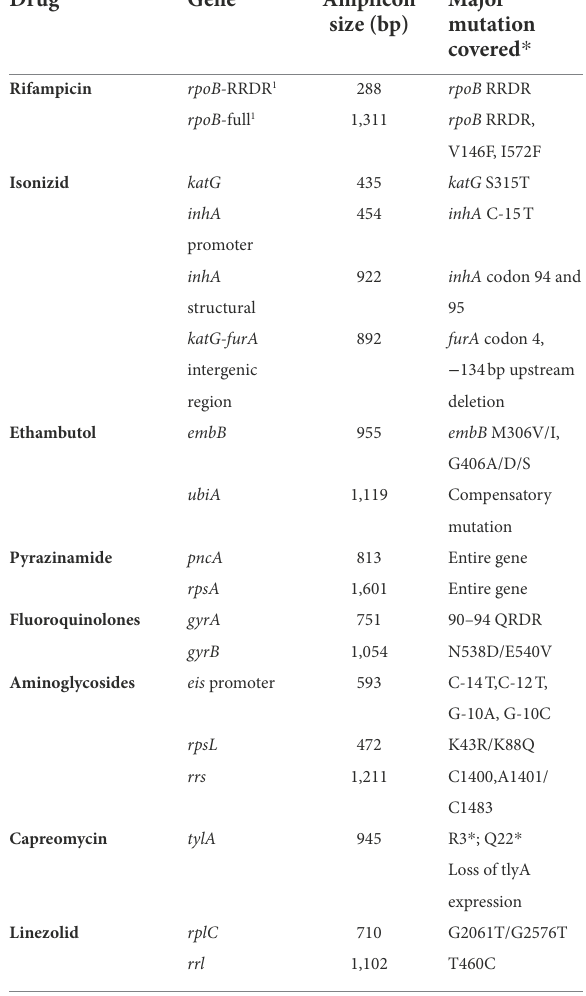
TABLE 1 Gene targets for target amplicon